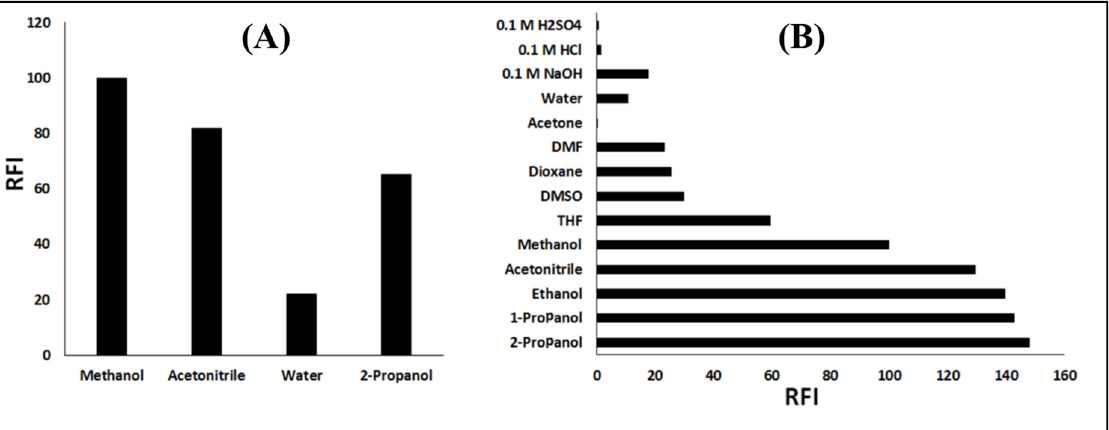
Figure 4. Effect of ( A ) the reaction solvent and ( B ) the diluting solvent on the relative fluorescence intensity of the reduced NFZ.